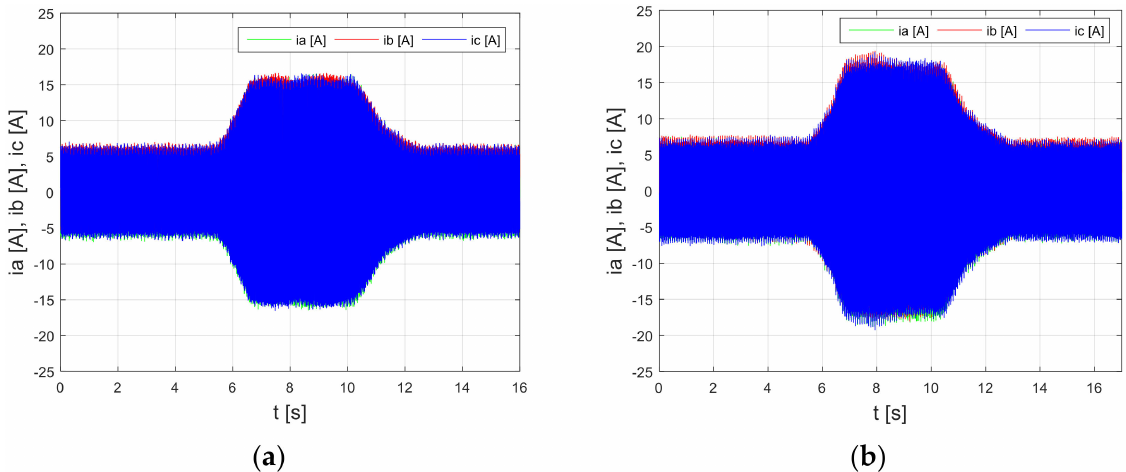
Figure 16. Phase-current waveforms (ia, ib, ic) for the speed of: ( a ) 1000 rpm; ( b ) 1500 rpm.